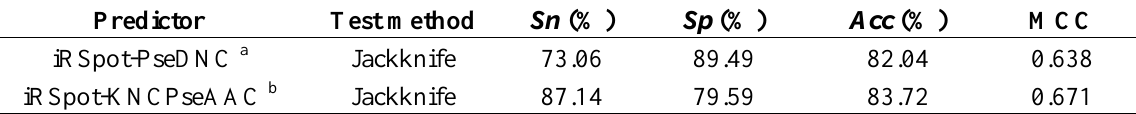
Table 4. A comparison of iRSpot-TNCPseAAC with the best existing